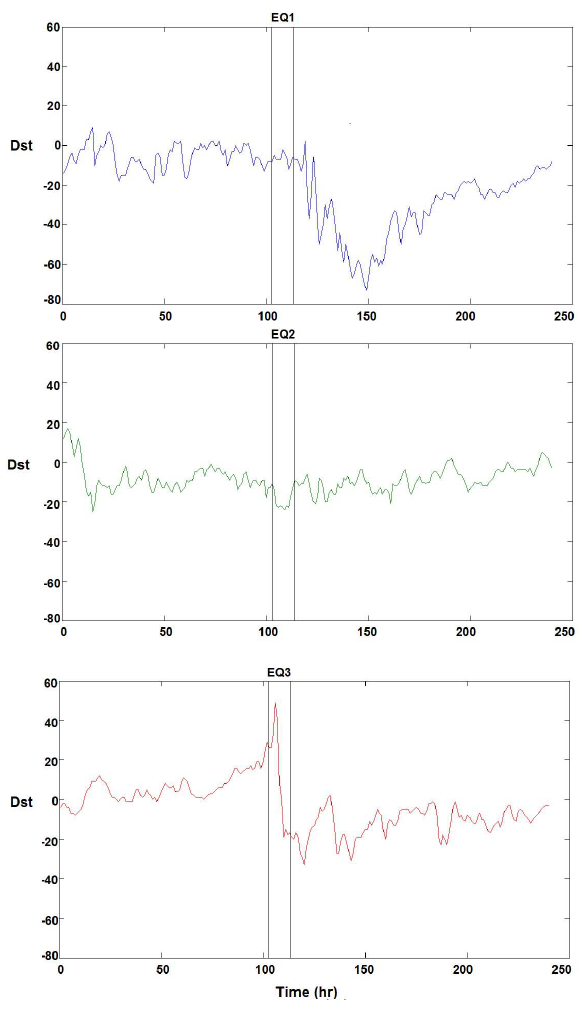
Fig. 6. Dst Index obtained from Kyoto observatory web page cor- responding with the 3 EQs analyzed. The period of time presented is 10